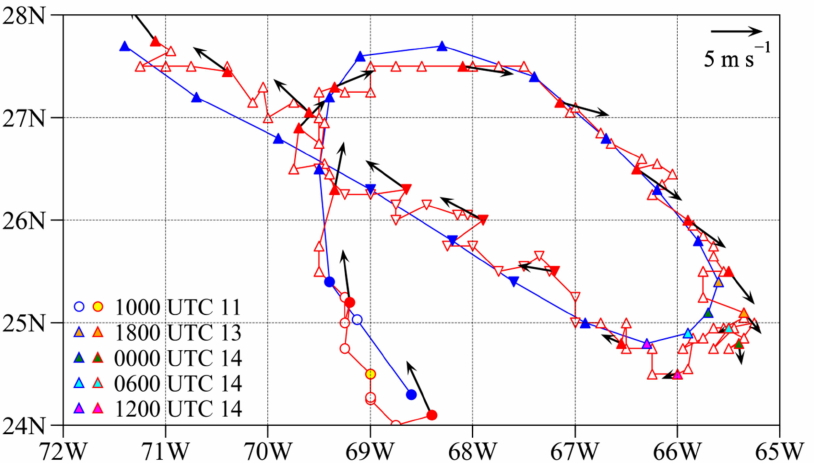
Figure 10. Track of ABI-determined centers at 1 h (red open marker) and 6 h (red solid marker) intervals and the best track (blue solid marker) of Jose from 0600 UTC September 11 to 0600 UTC September 16, 2017. Also indicated is the environmental steering flow (black arrow, the length of 5 m s − 1 ) calculated from the ERA5 wind reanalysis. The ABI-determined centers and the best track centers at 1000 UTC 11, 1800 UTC 13, 0000 UTC 14, 0600 UTC 14, and 1200 UTC 14 September 2017 are highlighted by the colors in the